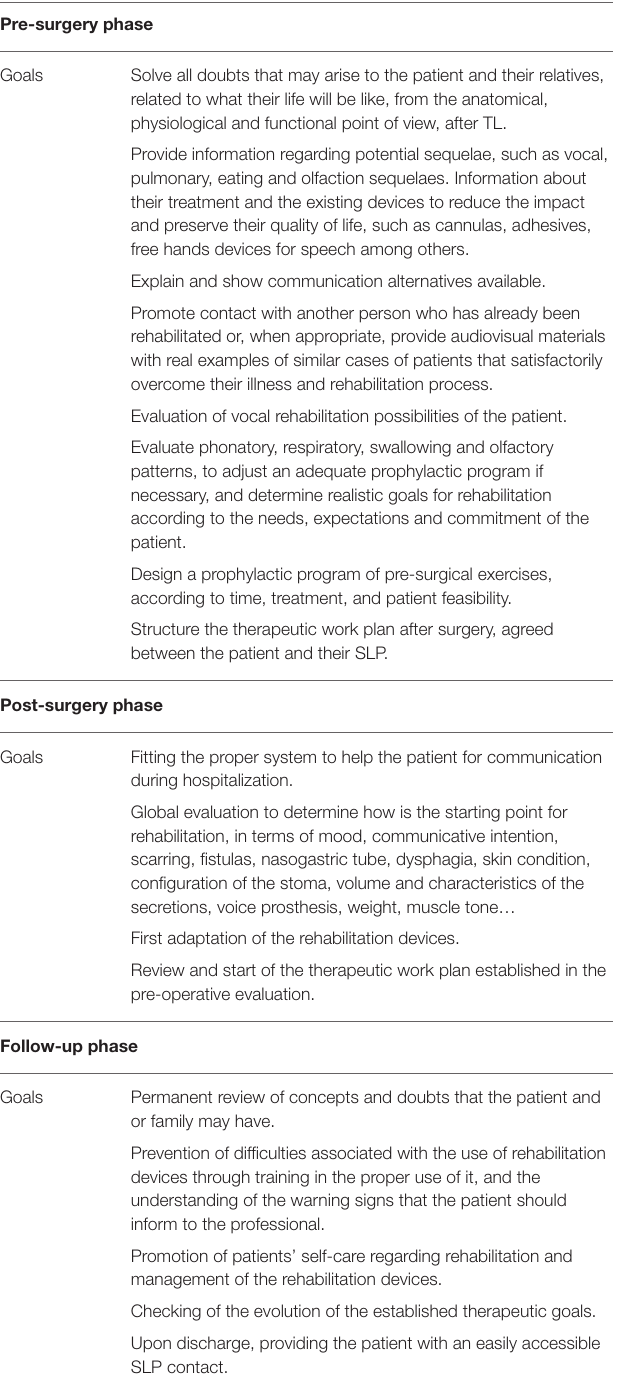
TABLE 3 | Areas of focus in SLP interventions. Pre-surgery